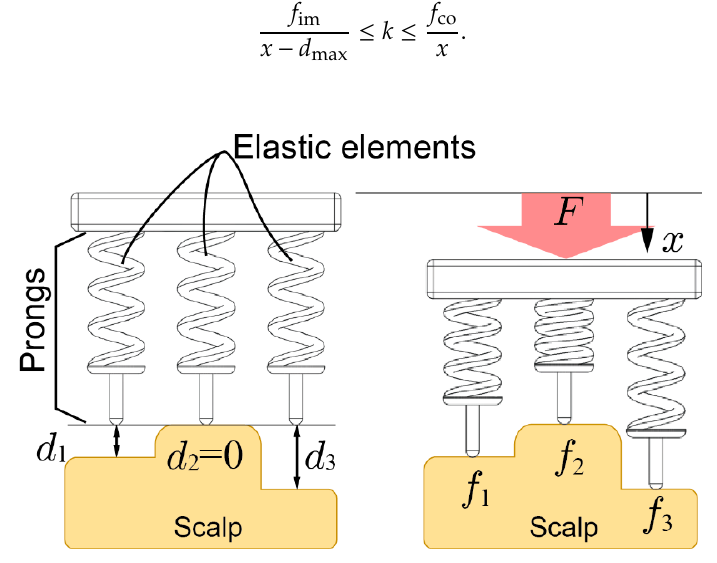
Figure 2. Contact model of the electrode with elastic prongs and the scalp.